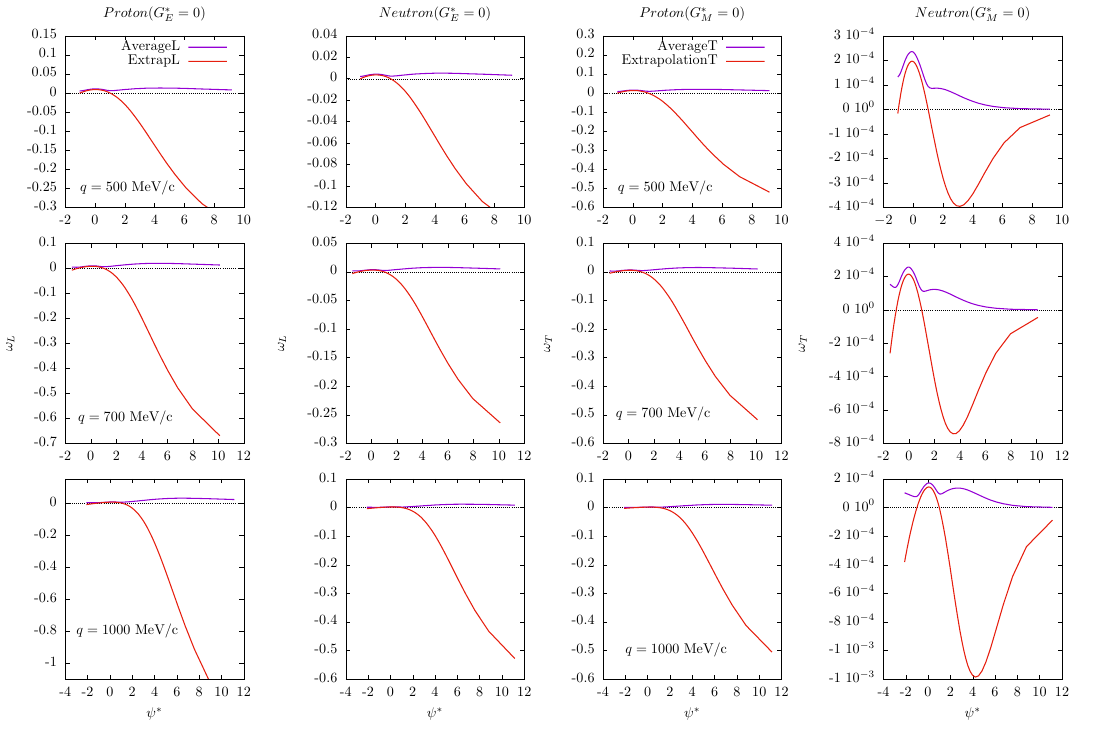
Figure 5. Averaged and extrapolated transverse response functions for protons and neutrons, for = 0, as a function of the scaling variable and for three values of the momentum transfer. Averaged G ∗ M and extrapolated longitudinal response functions for protons and neutrons, for G ∗ of the scaling variable and for three values of the momentum